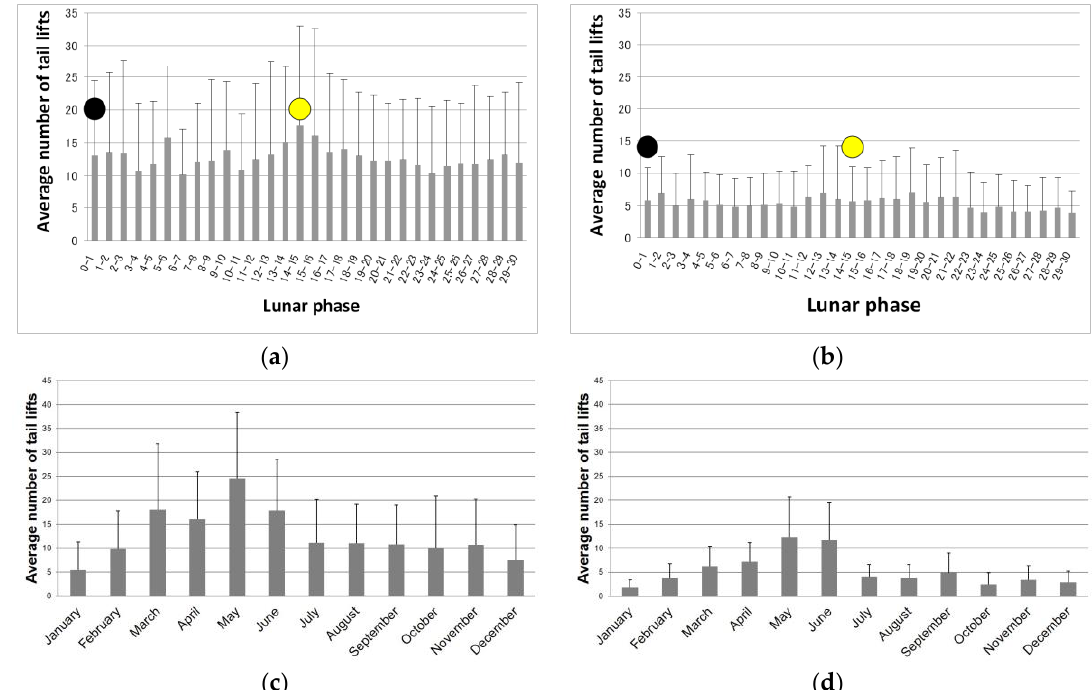
Figure 1. ( a ) Average number ( + standard deviation (SD)) of tail lifts by moon phase in the ELF-EMF group. The full moon falls on either the 14th or 15th day of the lunar phase (yellow stamp) while the new moon falls on the zeroth day of the lunar phase (black stamp). ( b ) Average number ( + SD) of tail lifts by moon phase in the control group. The full moon falls on either the 14th or 15th day of the lunar phase while the new moon falls on the zeroth day of the lunar phase. ( c ) Average number ( + SD) of tail lifts by month in the ELF-EMF group. ( d ) Average number ( + SD) of tail lifts by month in the control group. Table 1. Results of a multiple linear regression analysis investigating the number of tail lifts against the calendar month, full moon, new moon, K index, daily mean temperature, daily mean humidity, and daily mean atmospheric pressure in the ELF-EMF group. Variable Full